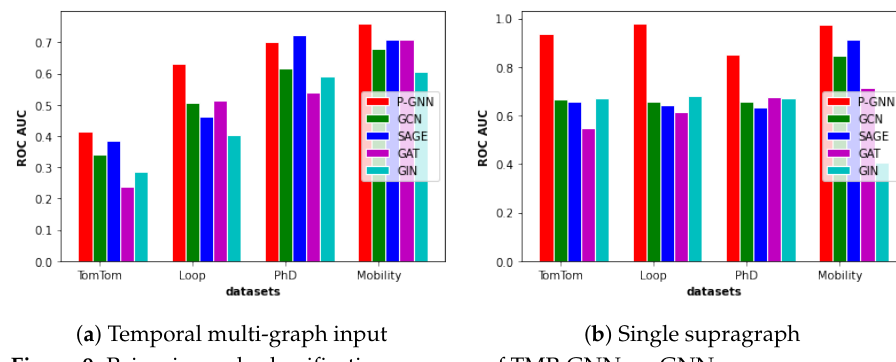
Figure 9. Pair-wise node classification accuracy of TMP-GNN vs. GNNs.